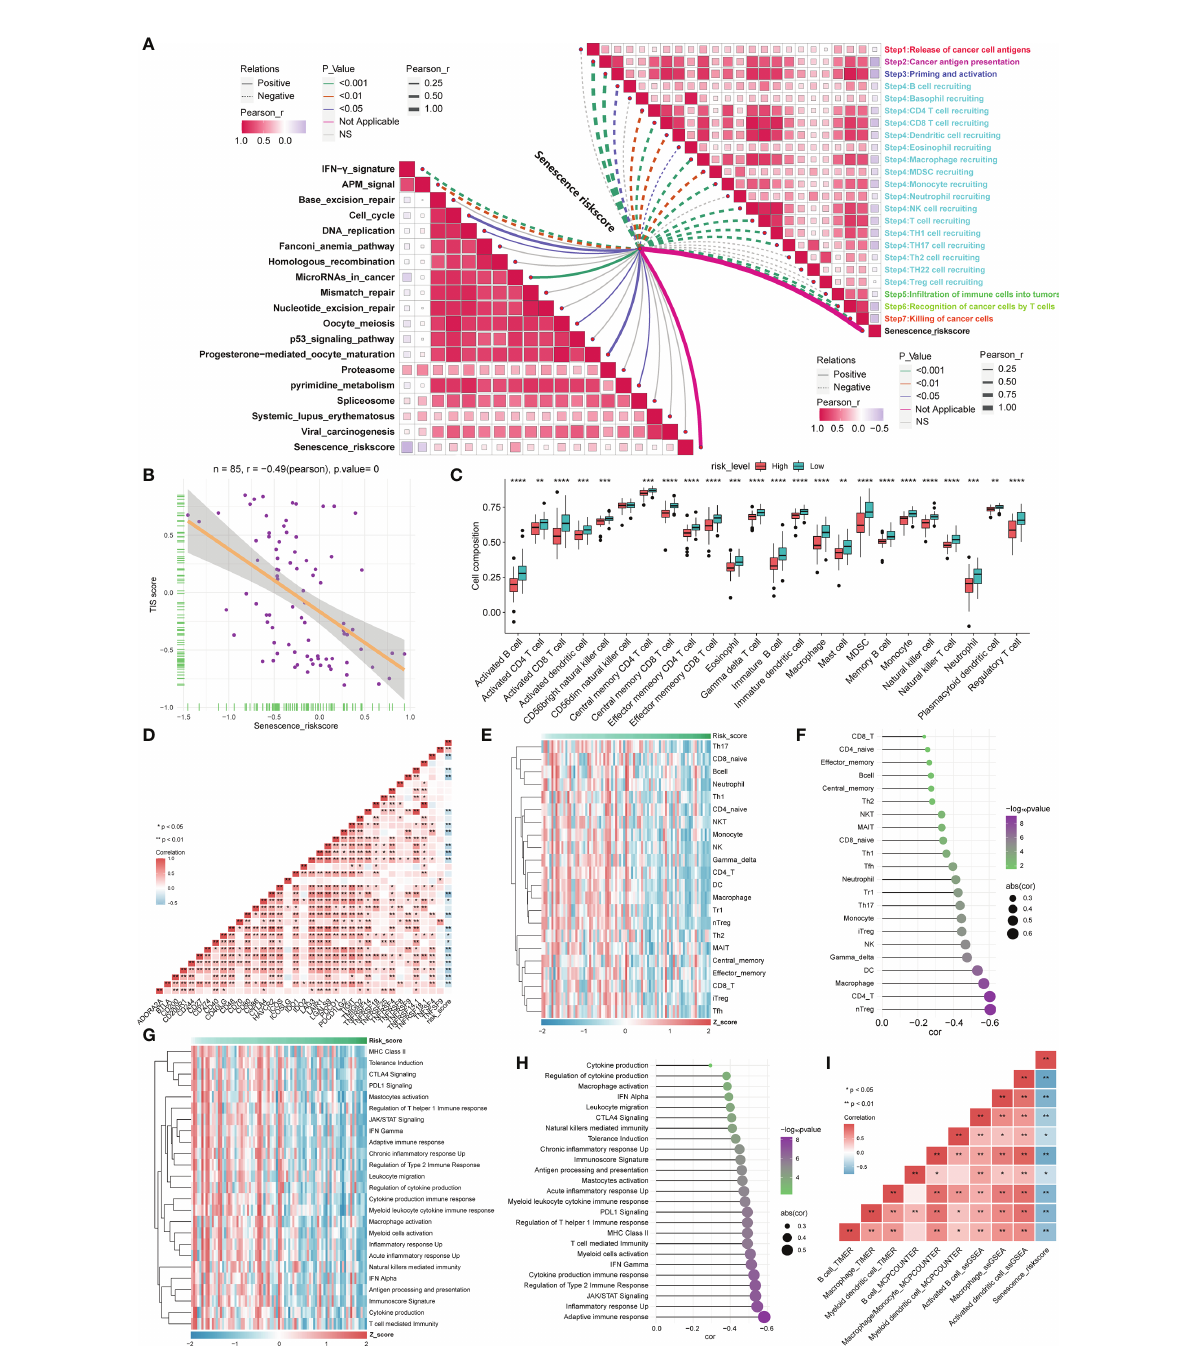
FIGURE 5 Correlation analysis between the risk score based on the ASIG subgroup and the TME and ICPs. (A) Correlation between the risk score constructed based on the four candidate genes and the tumor immunity cycle (right) and immunotherapy prediction pathways (left). (B) Correlation between T-cell score and risk score. (C) Distinctions in 28 immune cell in fi ltration levels between different risk score groups determined using the ssGSEA algorithm (*p< 0.05, **p< 0.01, ***p< 0.001, ****p< 0.0001). (D) Correlation analysis between the risk score constructed based on the four candidate genes and ICP. (E, F) Heatmap and correlation analysis between risk scores constructed based on the four candidate genes and tumor-in fi ltrating lymphocytes (TILs). (G, H) Heatmap of risk scores and innate immune pathways and correlation analysis. (I) The correlation between APC cell in fi ltration and risk score was assessed using three algorithms (TIMER, MCPCOUNTER, and